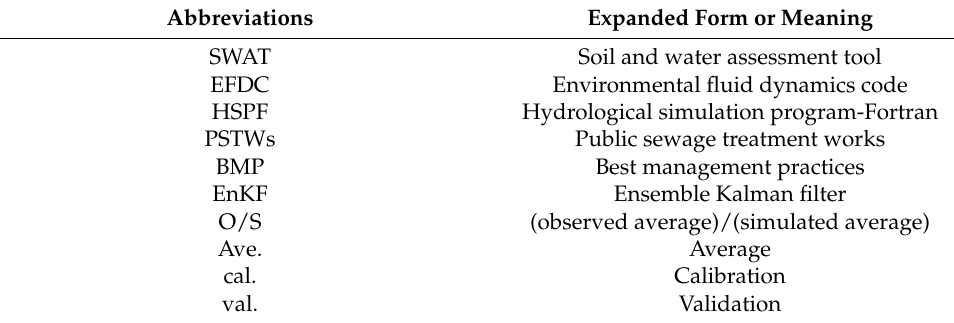
Table 1. Description of abbreviations used throughout the